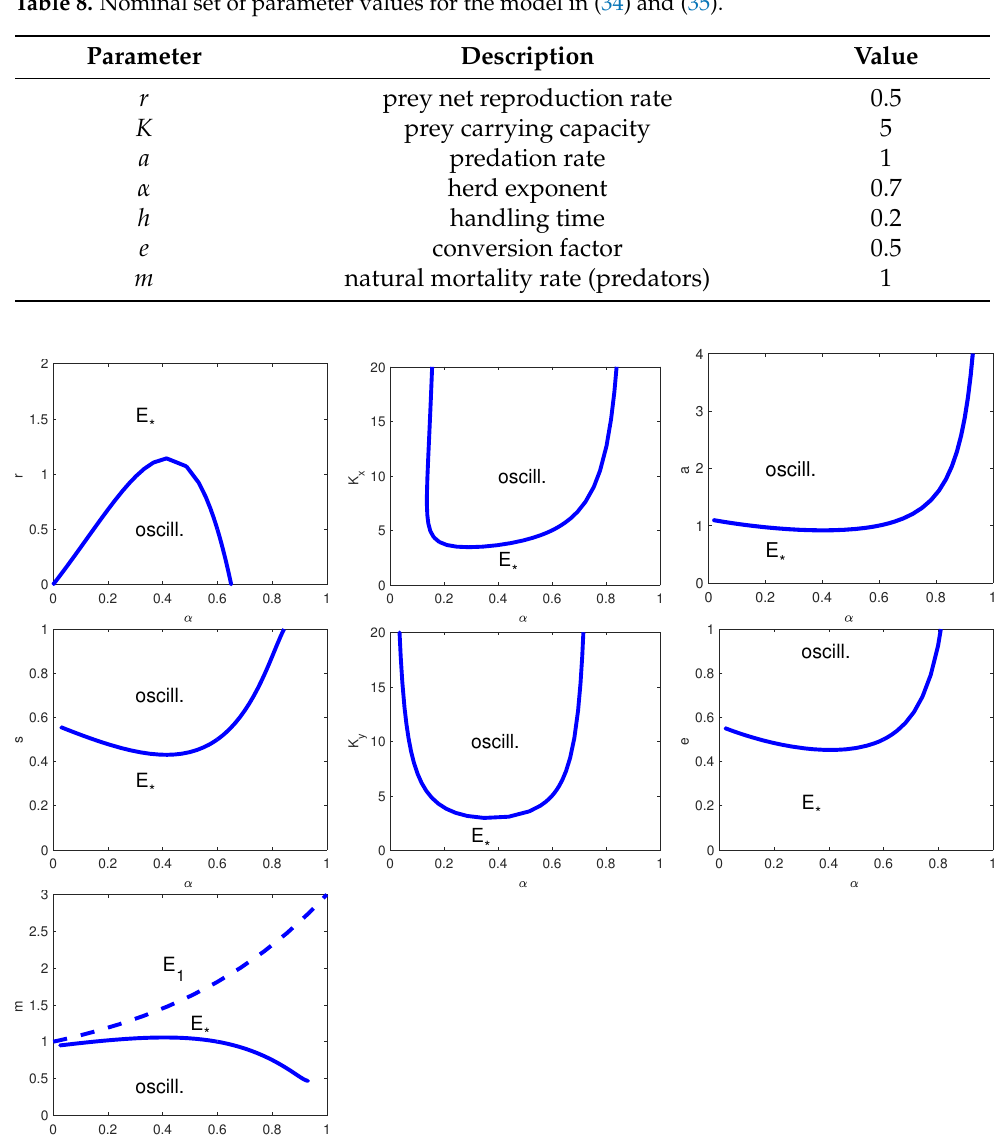
Figure 4. Two-parameter bifurcation diagram with respect to α , and, from top left to bottom right, r , K x , a , s , K y , e and m . Thick line: HB curve; dashed line: transcritical bifurcation curve. E ∗ is the coexistence equilibrium and E 1 the prey-only equilibrium. The remaining parameter values are as in Table